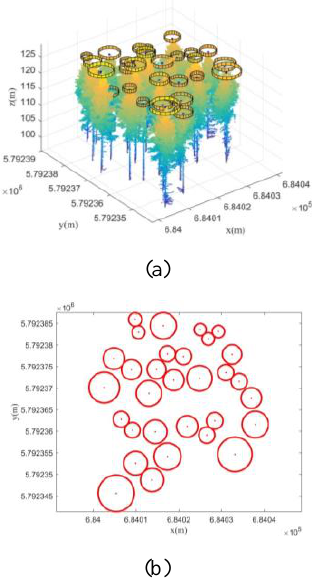
Figure 4 . Estimated crown sizes for the trees. (a) Three- dimensional display; (b) Two-dimensional